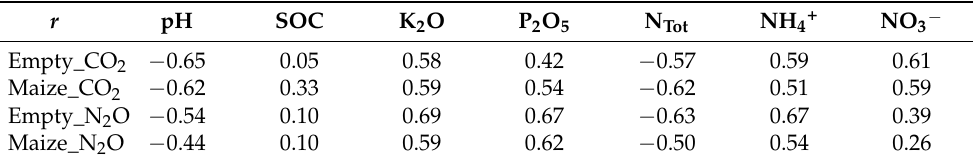
Table 3. Pearson correlation analysis ( r ) and p -value ( p ) between the investigated soil chemical parameters and GHG emissions for the empty and planted with maize plots ( n = 27). Correlation is significant at the * 0.05, ** 0.01, and *** 0.001 level.